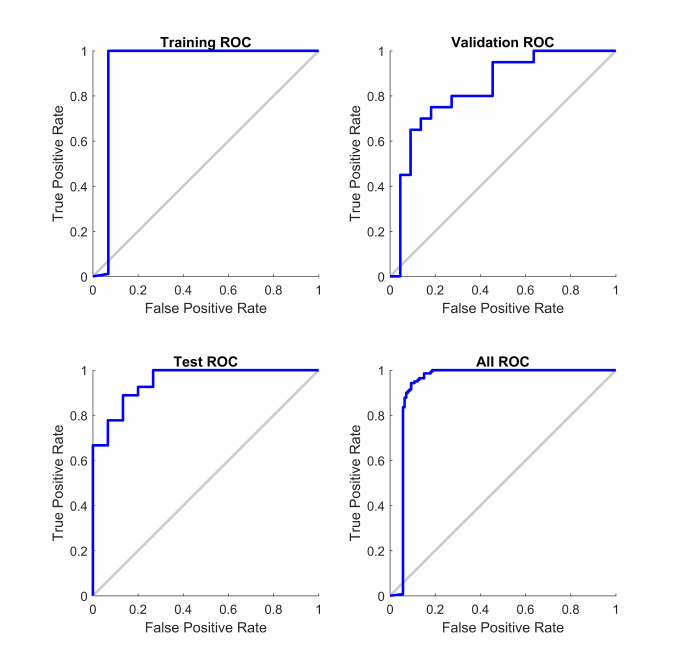
Figure 6. ROC (after p -value prefiltering and Shannon Entropy